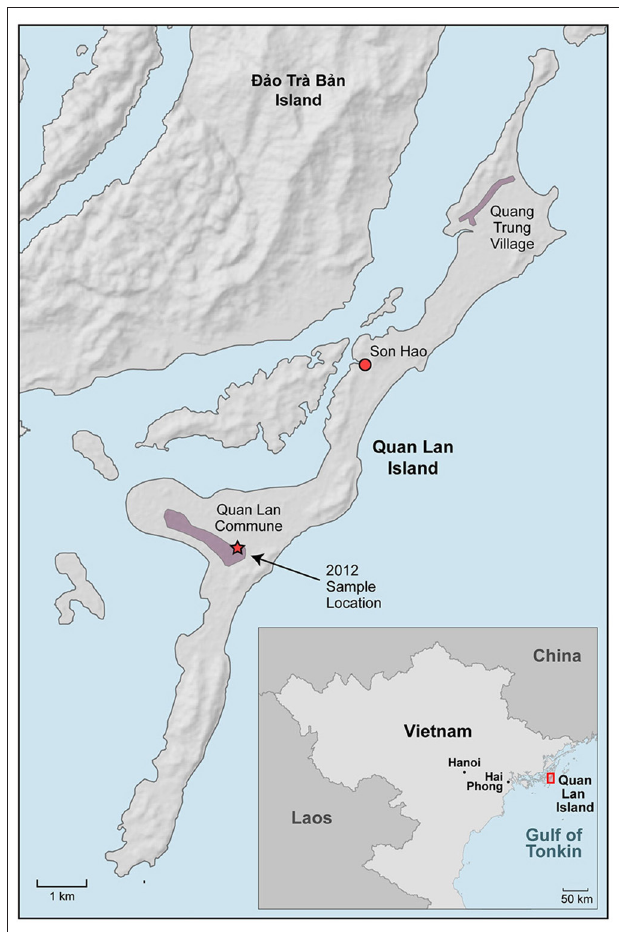
FIGURE 1 | Map of Northern Vietnam and Quan Lan Island. Map showing the location of the Quan Lan Commune and wetland (20.876 ◦ N, 107.494 ◦ E; red star), Van Don District. The ancient port of Son Hao is marked by a red dot. (Inset: Location of Quan Lan Island (red box) within northern Vietnam and Ha Long